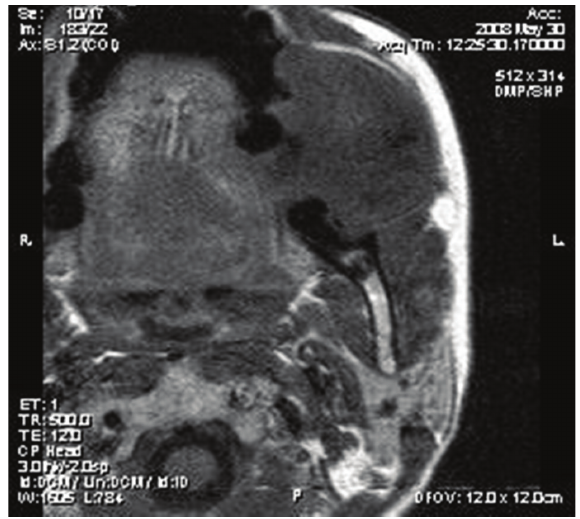
Figure 3: T 1 -weighted coronal image showing isointense mass occupying left vestibule.